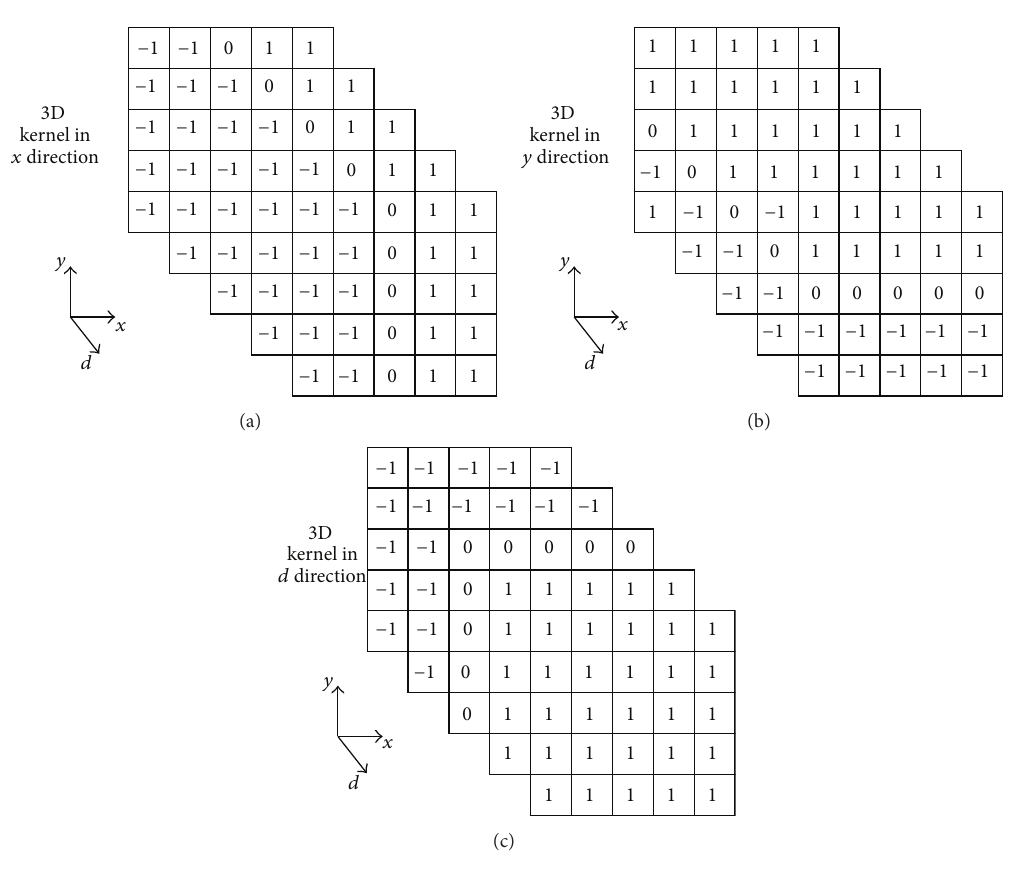
Figure 2: Kernels used for 3D gradient computation in three